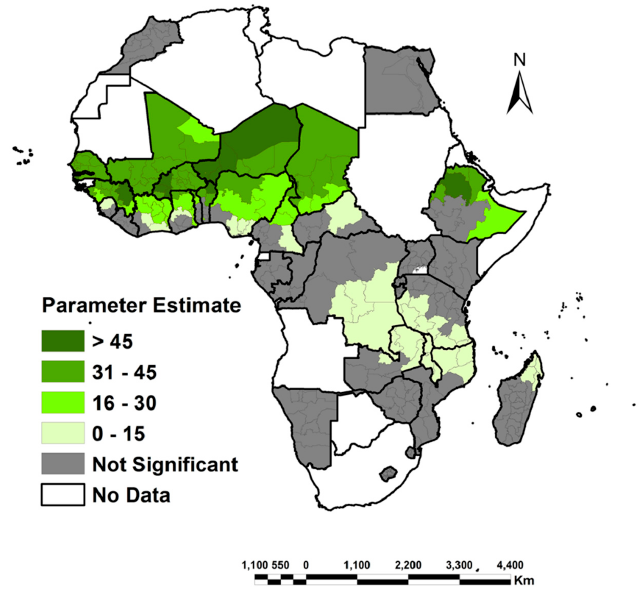
Figure 19. Spatial distribution and significance of HIV on women’s access to own land.